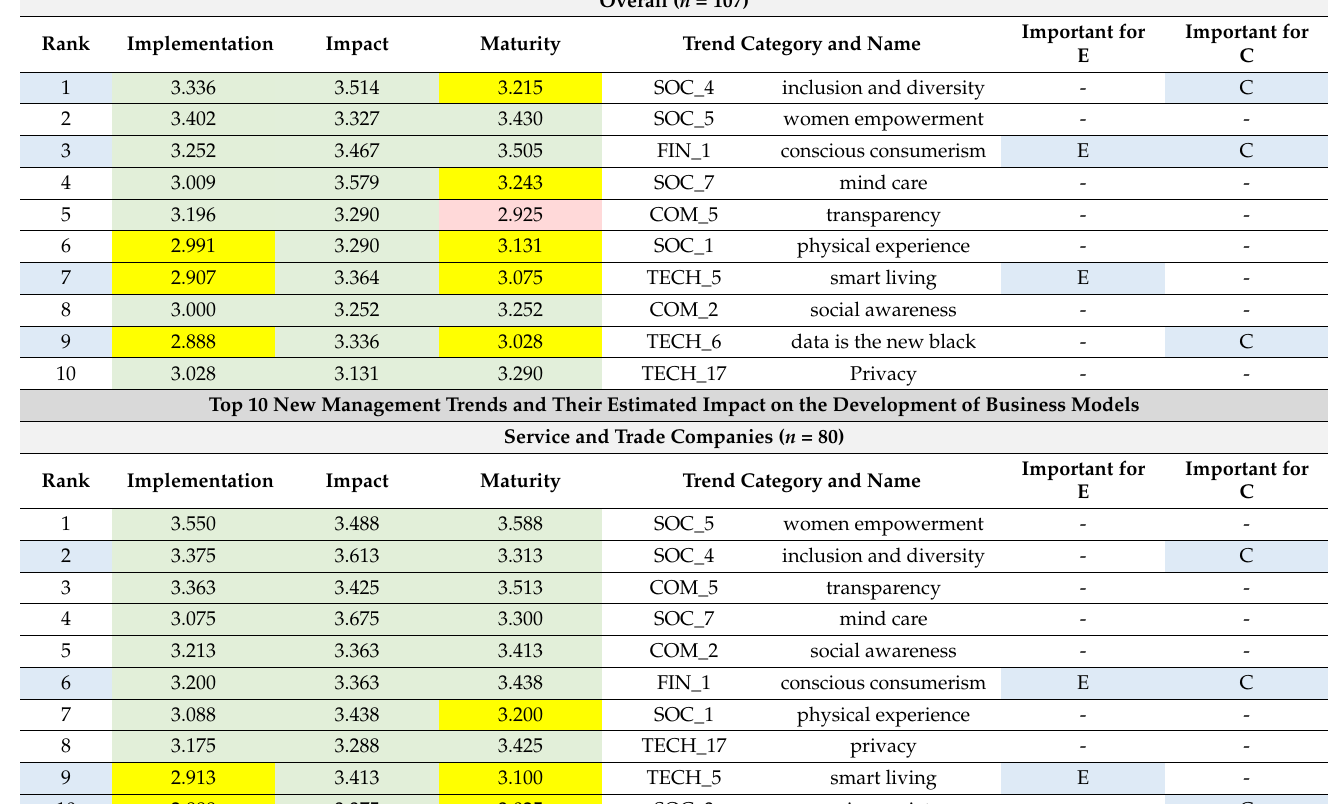
Table 5. Top 10 S.T.F.E.C. SMART management trends—overall results and results for service and trade companies, and production